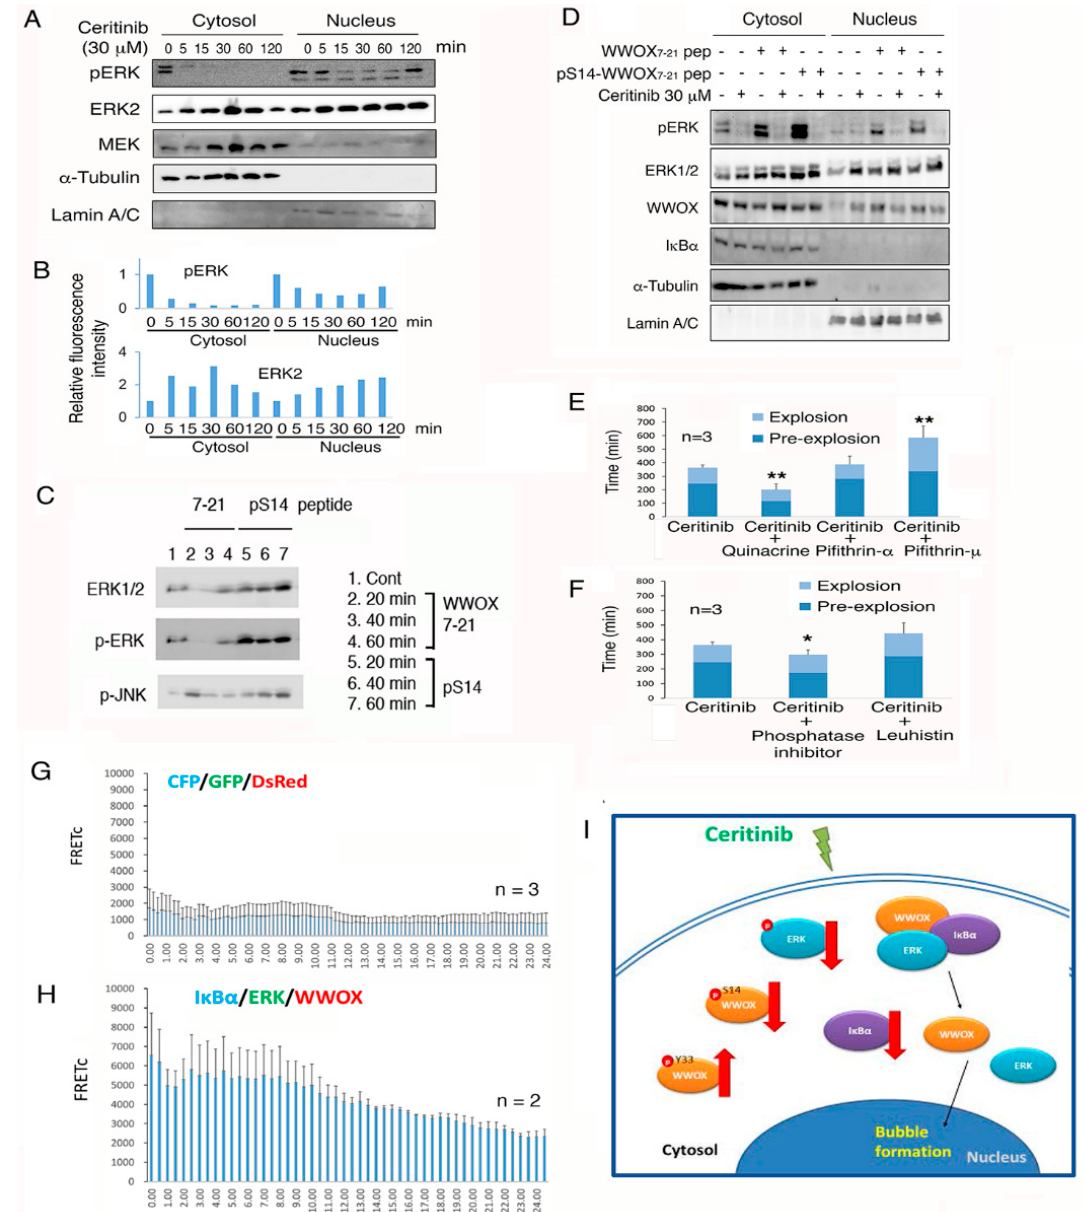
Figure 7. WWOX peptides counteract the ceritinib-mediated apoptosis via regulating ERK phosphorylation and IkB α /WWOX/ERK signaling. ( A , B ) Ceritinib rapidly suppressed the phosphorylation of ERK1/2 in 4T1 cells. A time-related nuclear accumulation of ERK2 is shown. Similar results were observed for ERK1/2 using specific antibodies. ( C ) Compared to WWOX7-21 peptide, pS14-WWOX7-21 peptide sustained phosphorylation of ERK and JNK in 4T1 cells. ( D ) 4T1 cells were treated with an indicated peptide (30 µM) for 30 min, and then exposed to ceritinib (30 µM) for 60 min, prior to processing cytosolic and nuclear fractionation and Western blotting. ( E ) 4T1 cells were cotreated with ceritinib (30 µM) and an indicated chemical for time-lapse microscopy. p53 inhibitor pifithin-µ and - α (50 µM) retarded the ceritinib-mediated sphere explosion and apoptosis. p53 activator quinacrine (50 µM) accelerated ceritinib-mediated apoptosis. ( F ) Phosphatase inhibitors (10 µL) enhanced ceritinib-mediated sphere explosion and apoptosis, whereas protease inhibitor leuhistin (30 µM) marginally retarded the effect of ceritinib ( n = 3, ** p < 0.05; * p < 0.1). ( G , H ) COS7 cells were transiently transfected with ECFP-IkB α , EGFP-ERK and DsRed-WWOX cDNA expression constructs. By thee protein/protein time-lapse FRET microscopy, ceritinib induced the signaling from IkB α to ERK and then to WWOX via energy transfer. In controls, no signaling is observed for ECFP, EGFP and DsRed. ( I ) A schematic graph for ceritinib signaling is shown, namely upregulation of pY33-WWOX, downregulation of p-ERK, dissociation of the IkB α /WWOX/ERK complex, and nuclear translocation of pY33-WWOX to cause apoptosis. Additionally, ceritinib induces cancer stem cell sphere explosion and death. Ceritinib-mediated apoptosis of single cells is switched to bubbling cell death at room temperature.